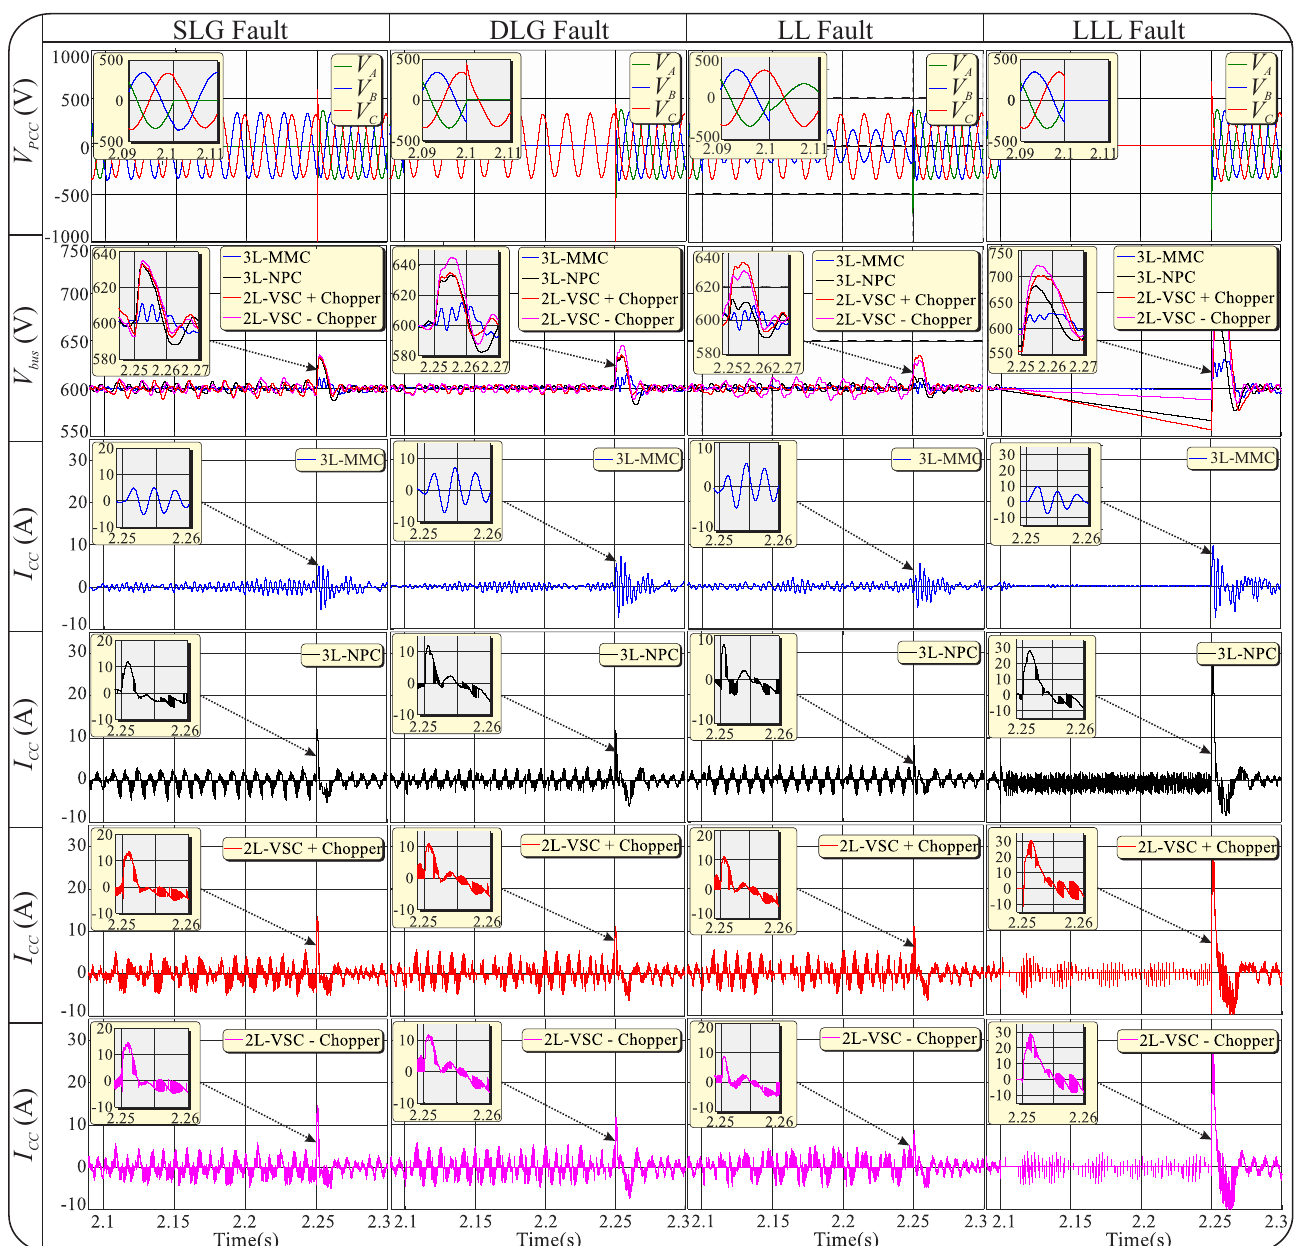
Figure 6. Obtained results for the 2L-VSC, 3L-NPC, and 3L-MMC for the SLG, DLG, LL, and LLL